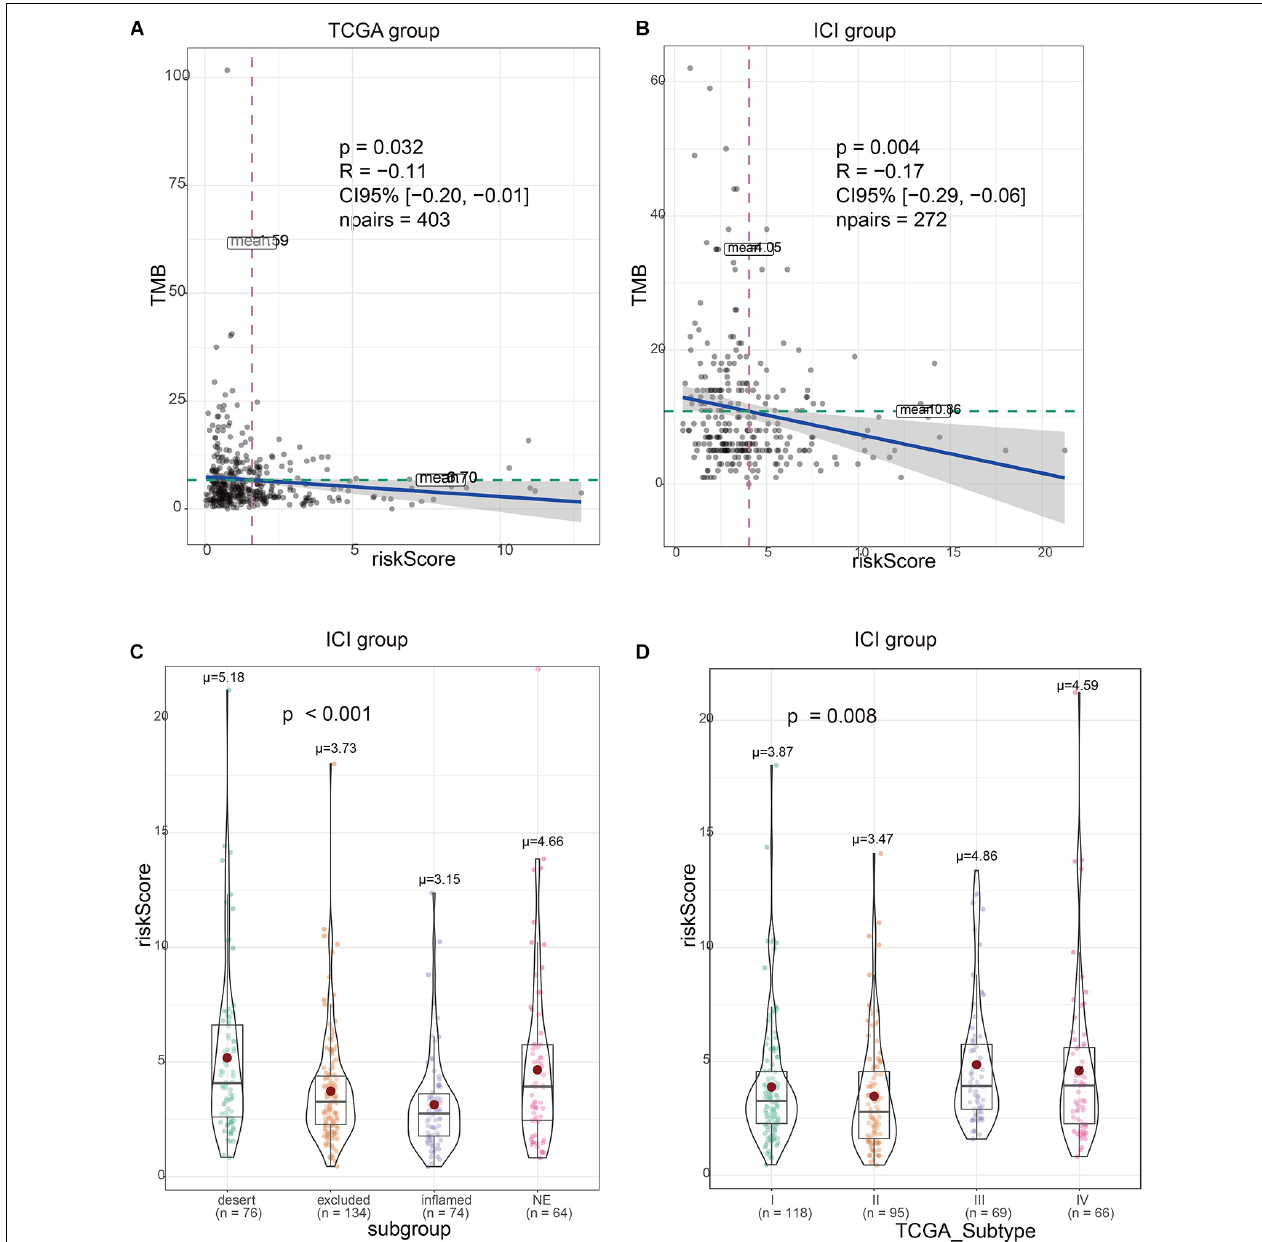
FIGURE 4 | Validation of the correlation between the risk signature and immunity characteristics. (A) Risk scores are correlated with tumor mutational burden (TMB) in The Cancer Genome Atlas (TCGA) set. (B) Risk scores are correlated with TMB in immune checkpoint inhibitor (ICI) treatment set. (C) Risk scores are correlated with immunity subtype in ICI treatment set. (D) Risk scores are correlated with TCGA subtype in ICI treatment set.